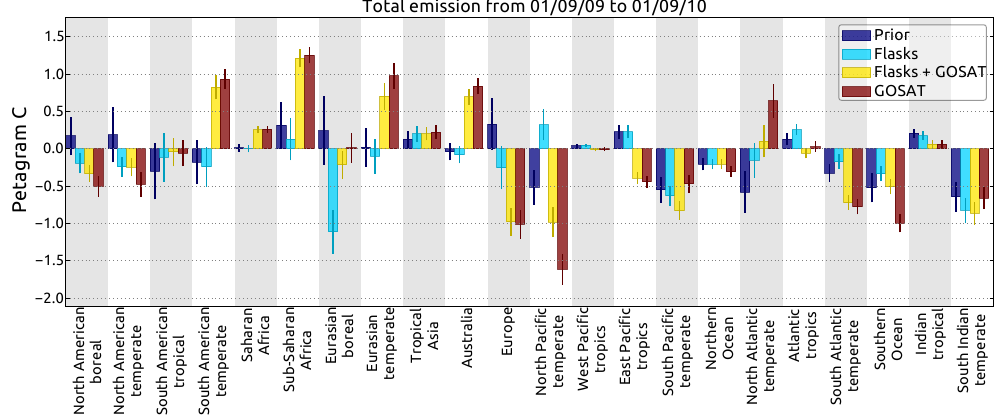
Fig. 7. Aggregated emission between 1 September 2009 and 1 September 2010 from the 22 TRANSCOM regions. The emission figures do not include fossil fuel emissions. Error bars denote 1 σ